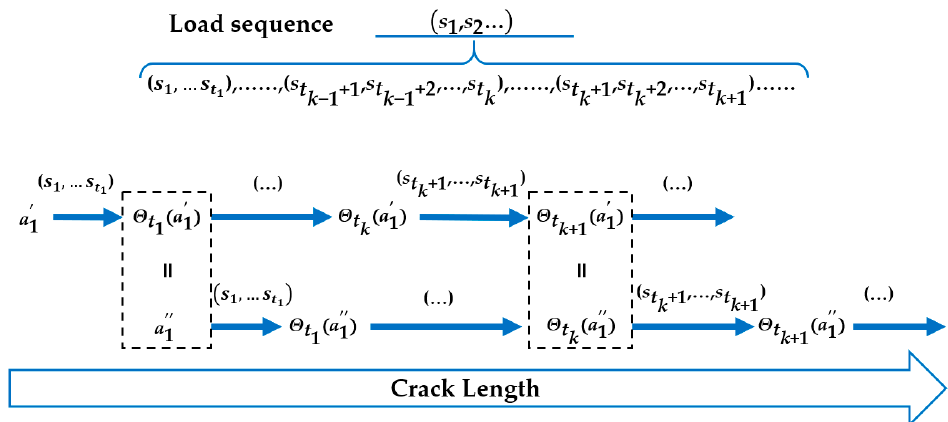
Figure 2. Evolution of different initial cracks.